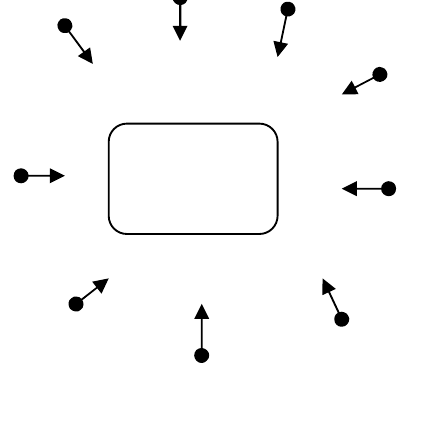
Figure 6. photography